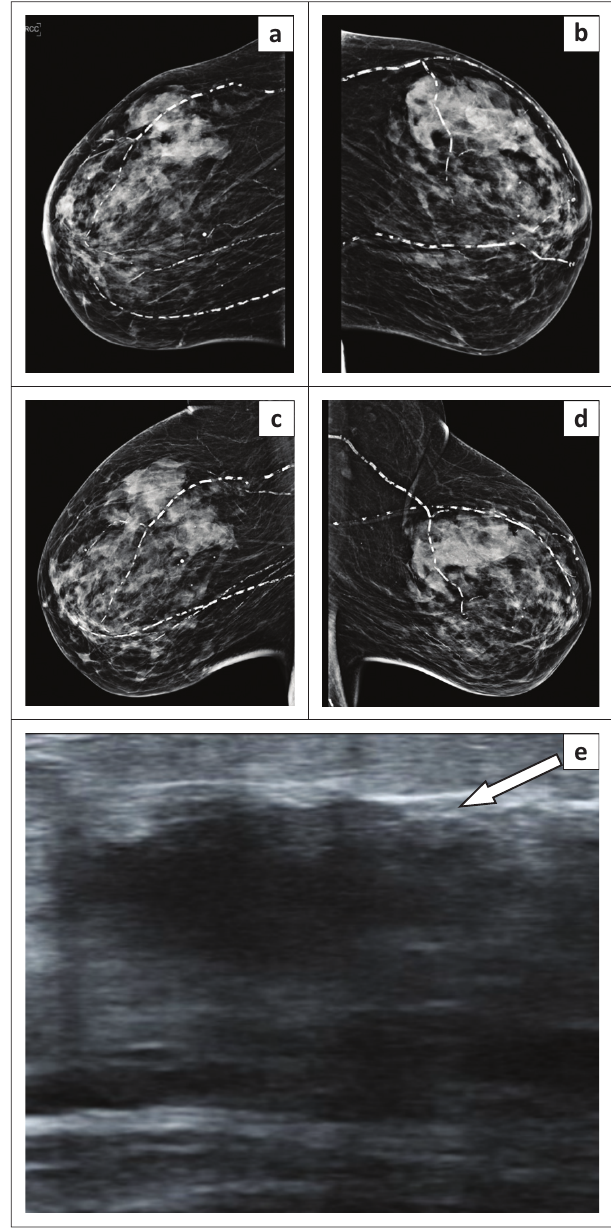
FIGURE 6: (a–d) Craniocaudal and mediolateral mammogram with a grade D dense breast pattern and (e) sonar demonstrating an area of hypoechogeneity with posterior acoustic shadowing